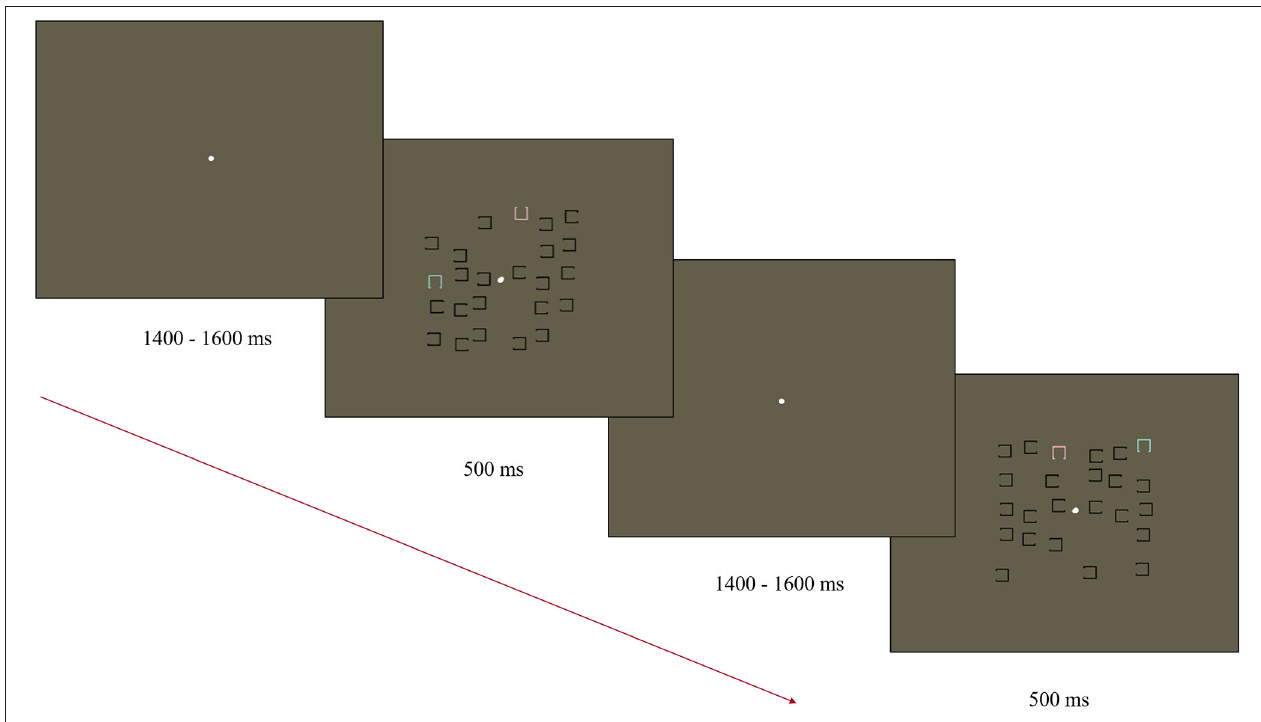
FIGURE 1 | Diagram of the Visual Search Task used to elicit the N2pc. Participants were asked to find either the pink or blue “U” and indicate the direction of the open side